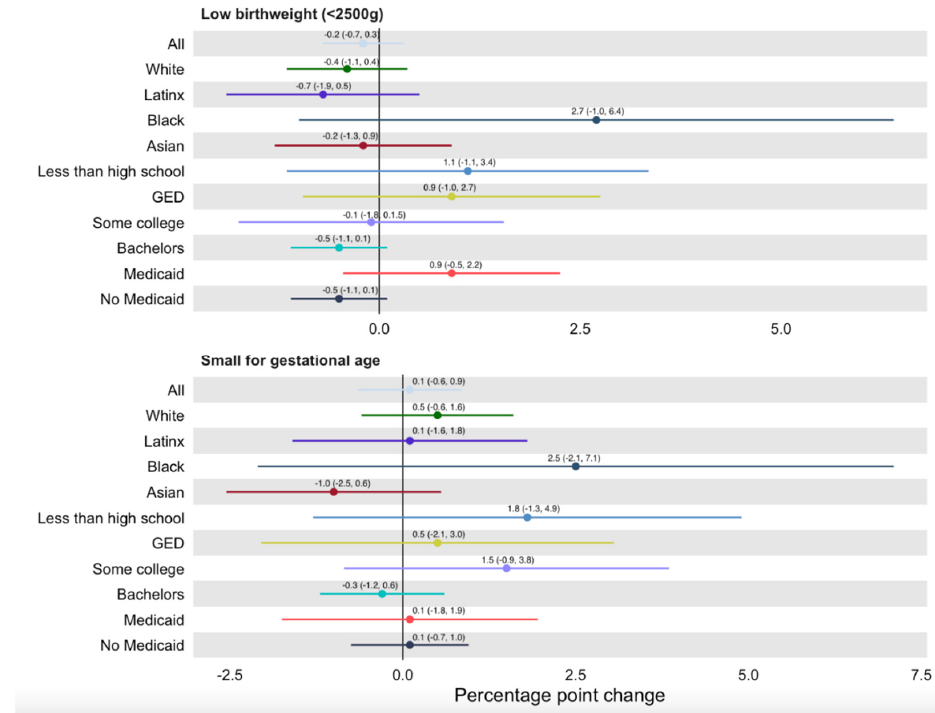
Figure 4. Low birthweight and small for gestational age DD estimates by race, education and Medicaid use at delivery.